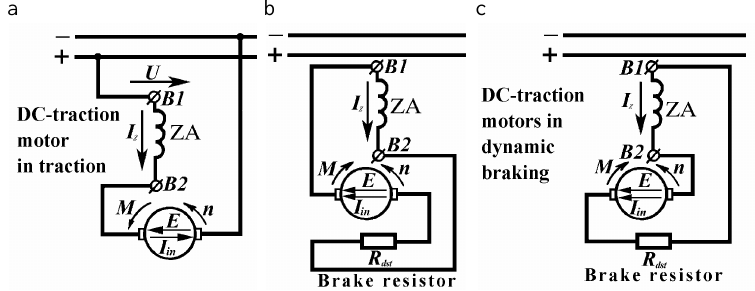
Fig 5. Diagrams showing series DC traction motor’s changeover to dynamic (rheostat) braking mode: a – motor operation; b – dynamic braking mode with excitation winding shifted (ZA); c – dynamic braking mode with armature winding